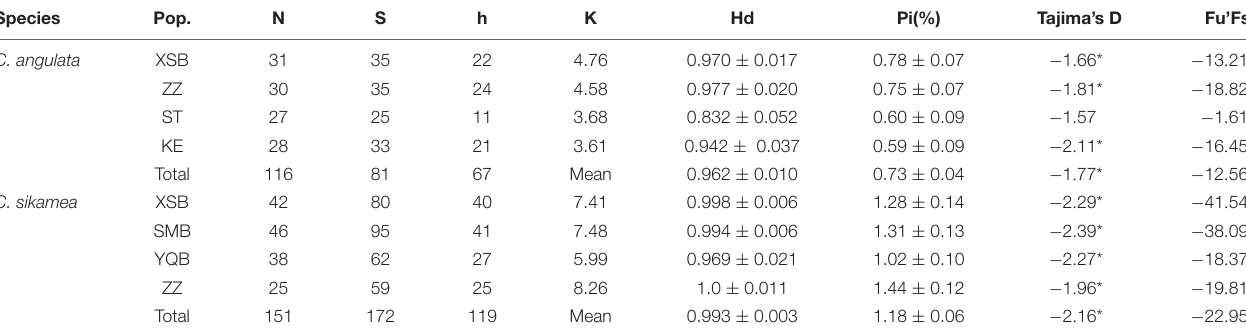
TABLE 5 | Genetic diversity parameters of Crassostrea angulata and Crassostrea sikamea based on MNR sequence. Species Pop. N